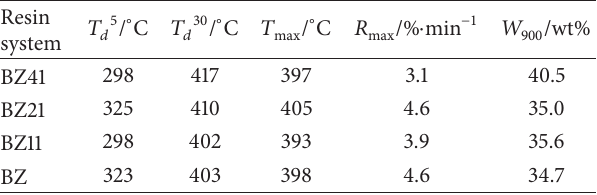
Table1:ParametersofTGAandTGcurvesforBOZ-M/F-51system.